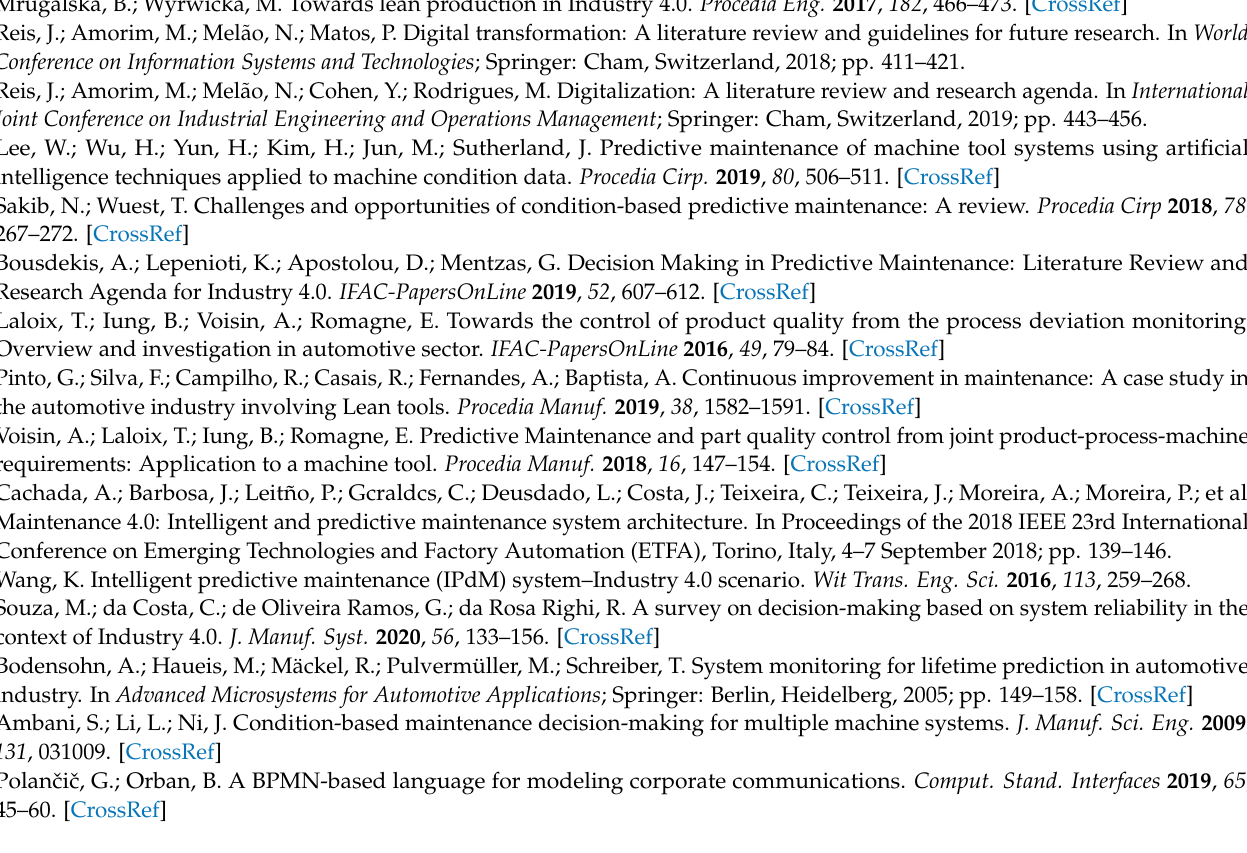
Figure A2. Predictive and condition-based maintenance action plans.